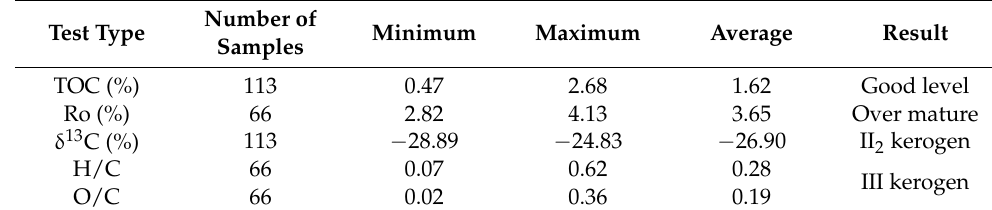
Table 1. Shale organic geochemical analysis data.